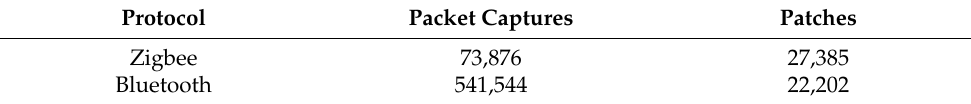
Table 4. Number of packets and patches for each protocol